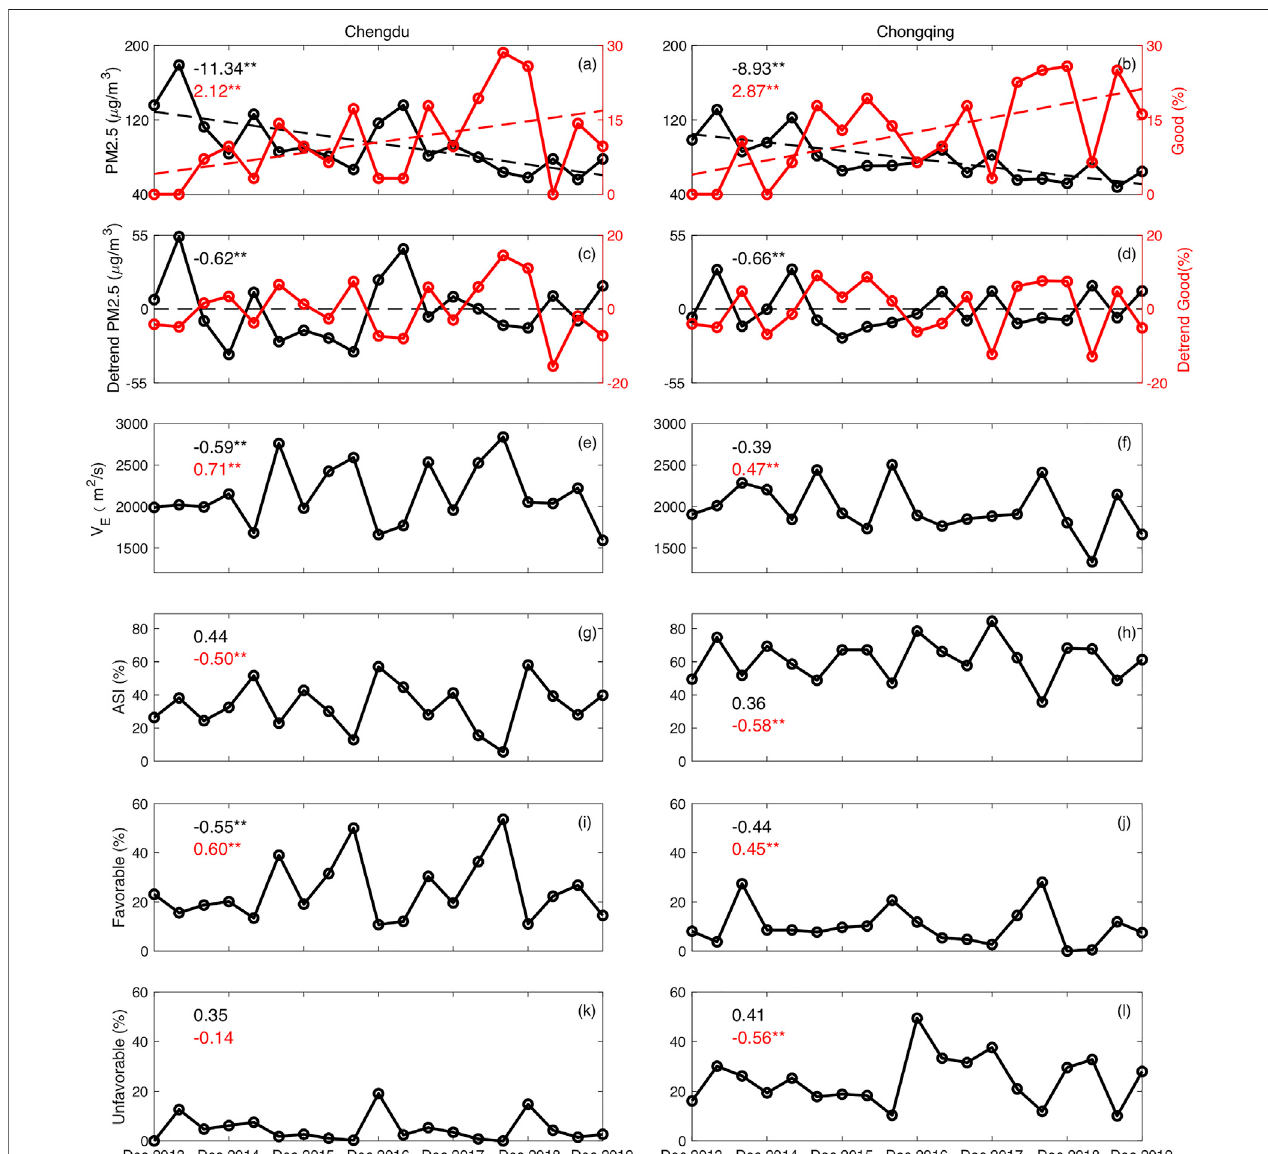
FIGURE 10 | Variation in monthly PM2.5 concentrations and good air quality frequency (A – B) , detrending PM2.5 concentrations and good air quality frequency (C – D) , V E (E – F) , frequencies of ASI (G – H) , favorable (I – J) and unfavorable (K – L) conditions during the winters from 2013 to 2019 (19 months in total) in Chengdu and Chongqing. Detrending series were calculated by subtracting the linear trend from the original series. Values in Figs (A – B) are the linear trend of PM2.5 concentration (black) and good air quality (red). ** indicates signi fi cance at 0.01 of the linear trends based on least square method. Values in Figs (C – D) indicate the correlation coef fi cientofdetrendedPM2.5 concentrationsand goodairqualityfrequency. **indicates thatthecorrelation coef fi cientissigni fi cantatthe0.01probabilitylevel.Values in Figs. (E – L) indicate the correlation coef fi cients between the detrended PM2.5 concentrations (black) and good air quality frequency (red) with the speci fi c metric of atmospheric diffusion conditions. ** indicates that the correlation coef fi cient is signi fi cant at the 0.01 probability